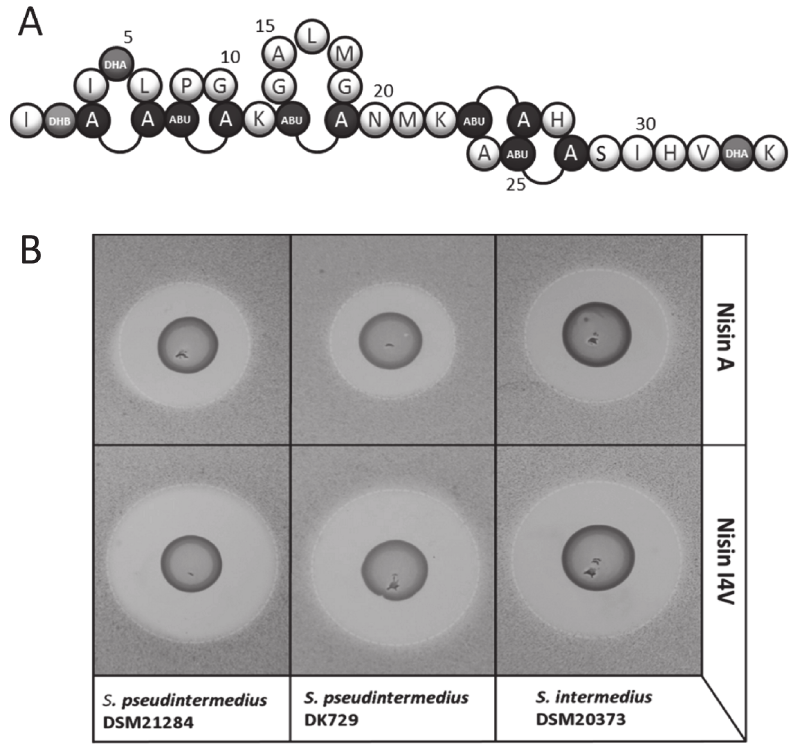
Fig 1. Structure of nisin A and deferred antagonism assays of nisin A and nisin I4V. (A) Residues are represented in the single letter code. Post translational modifications are indicated as follows, Dha: dehydroalanine, Dhb: dehydrobutyrine, Abu: 2-aminobutyric acid, A-A: lanthionine, Abu-A: 3- methyllanthionine. (B) Growth inhibition of S . intermedius DSM 20373, S . pseudintermedius DK729 and S . pseudintermedius DSM21284 by the nisin A producing strain L . lactis NZ9800 pDF05 (pCI372- nis A) and the nisin derivative I4V producing strain L . lactis NZ9800 pDF12 ( nis A-I4V).